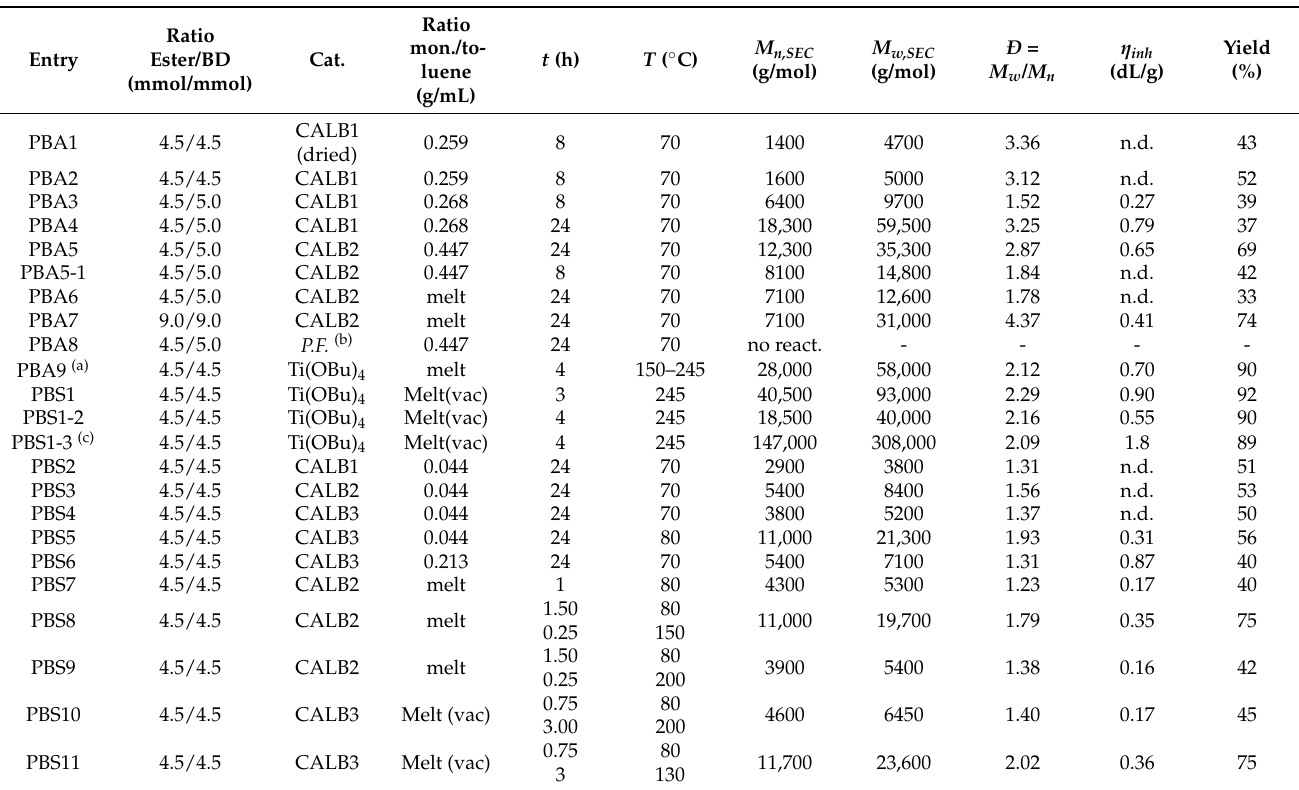
Table 2. Polycondensation results for the synthesis of PBA using divinyladipate and 1,4-butanediol, and PBS using dimethylsuccinate and